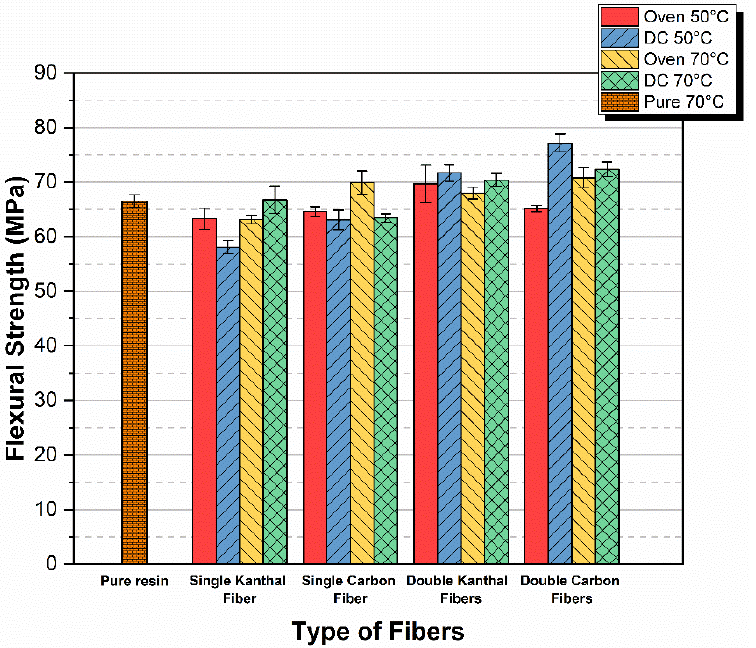
Figure 7. Flexural strength versus curing method, for both types of fibers and for both single fiber and double fiber specimens. Table 1. Statistical analysis of flexural strength values for different curing